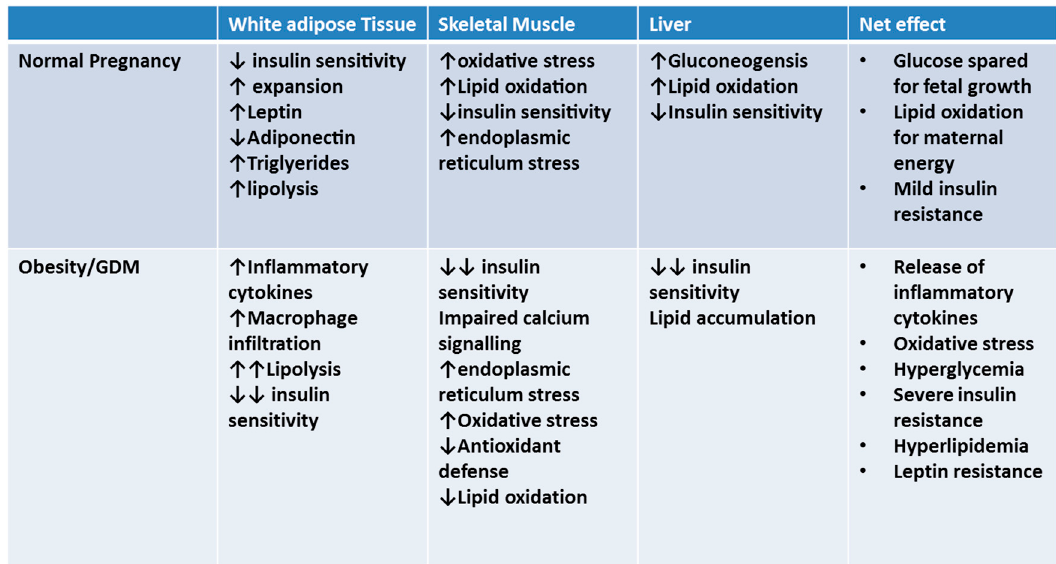
Figure 1. Adaptations in peripheral tissue in late gestation occur to spare glucose for fetal growth; if insulin resistance is too severe (such as in pregnancies complicated by pre-existing obesity), gestational diabetes can occur.